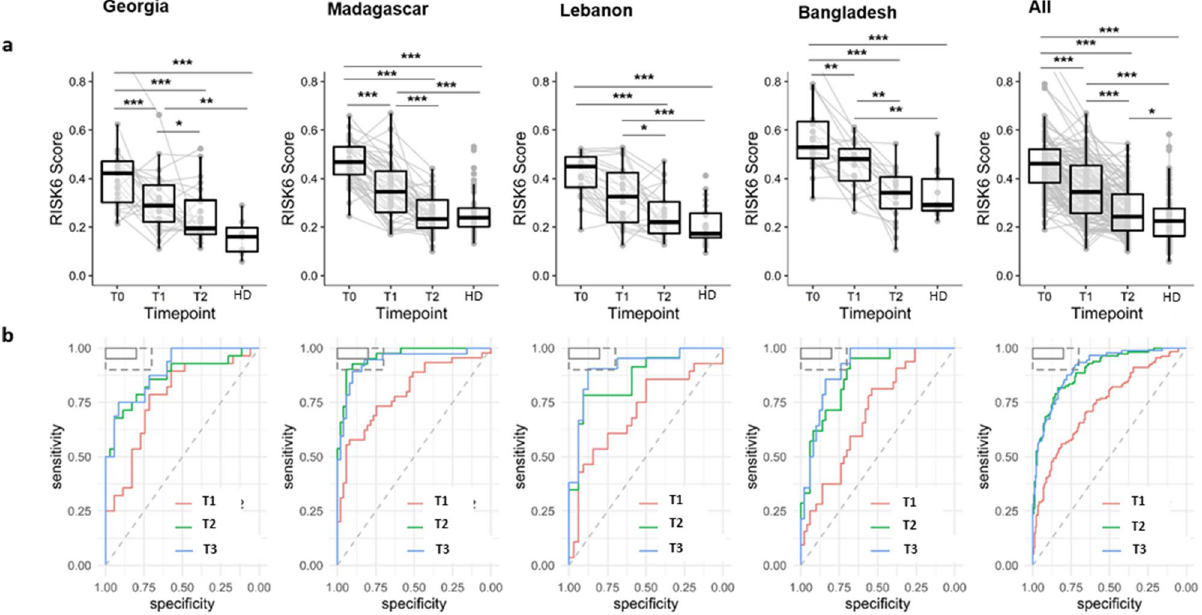
Figure 3. Validation of the performance of RISK6 signature as a biomarker for monitoring TB treatment response in four distinct geographical countries. ( a ) RISK6 scores were evaluated in whole blood of patients with active TB who had successfully completed their TB treatment until T2 (n = 104). Evaluation was done at baseline (T0), 2 months after treatment initiation (T1), and at the end of treatment (T2). RISK6 scores in healthy donors (HD: n = 71) were also evaluated. Horizontal lines designate medians, boxes represent the inter-quartile ranges (IQR) and the ranges are represented by whiskers. Single patient results are represented by each dot in the graph. Plotlines (grey) represent the RISK6 scores of the same patient at the three different time points. Statistical significance was calculated using Mann–Whitney U test. *Indicates a p-value < 0.05, **indicates a p-value < 0.01, and ***indicates a p-value < 0.001. ( b ) Receiver operating characteristic (ROC) curve analysis and the respective areas under the curve (AUC) with 95% confidence intervals (CI) showing the ability of the RISK6 signature to discriminate between active TB patients at baseline (T0, n = 141) and at month 2 after treatment initiation (T1, n = 117), at the end of treatment (T2, n = 104) and 2 months after treatment completion (T3, n =